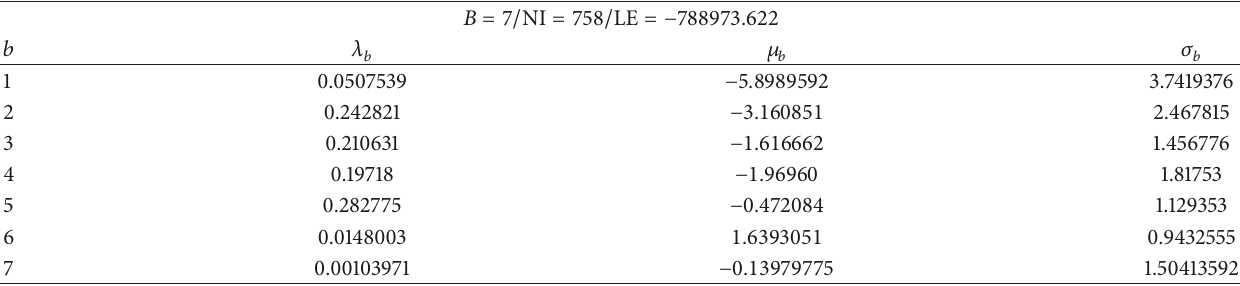
Table 4: Gaussian mixture distribution parameters of the gold spot market.